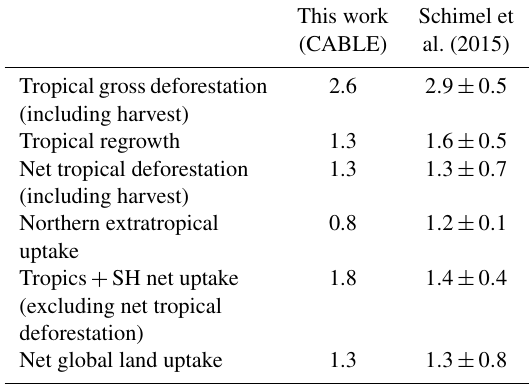
Table 3. The net land carbon sink (PgCyear − 1 ; 1990–2007) and its partitioning, as estimated by CABLE, and a synthesis using a combination of top-down and bottom-up constraints (Schimel et al.,